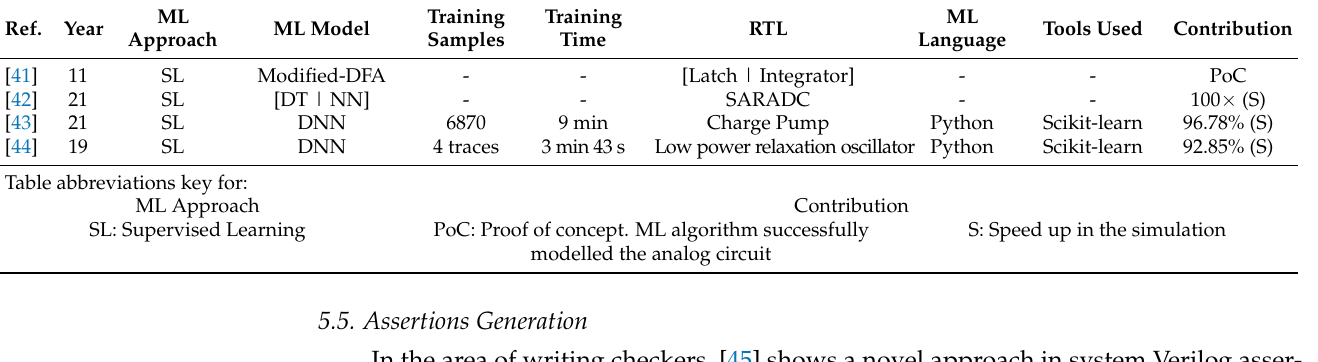
Table 4. Comparative summary of state of the art ML contributions in Section 5.4.